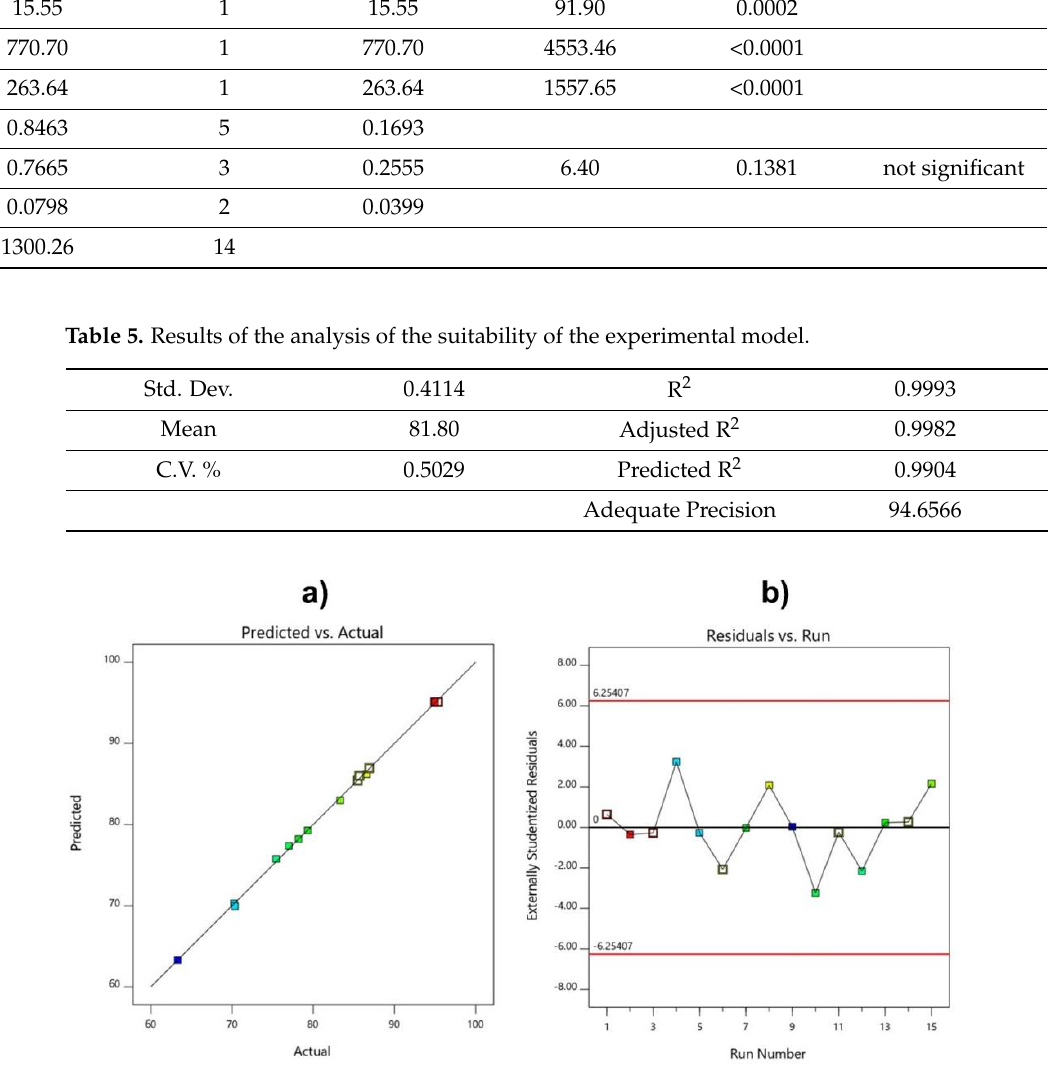
Figure 9. Predicted and actual value plots ( a ), and residuals versus run models ( b ), for conversion. Table 4. ANOVA for the response surface quadratic model (Cor Total: Corrected Total Sum of Squares).